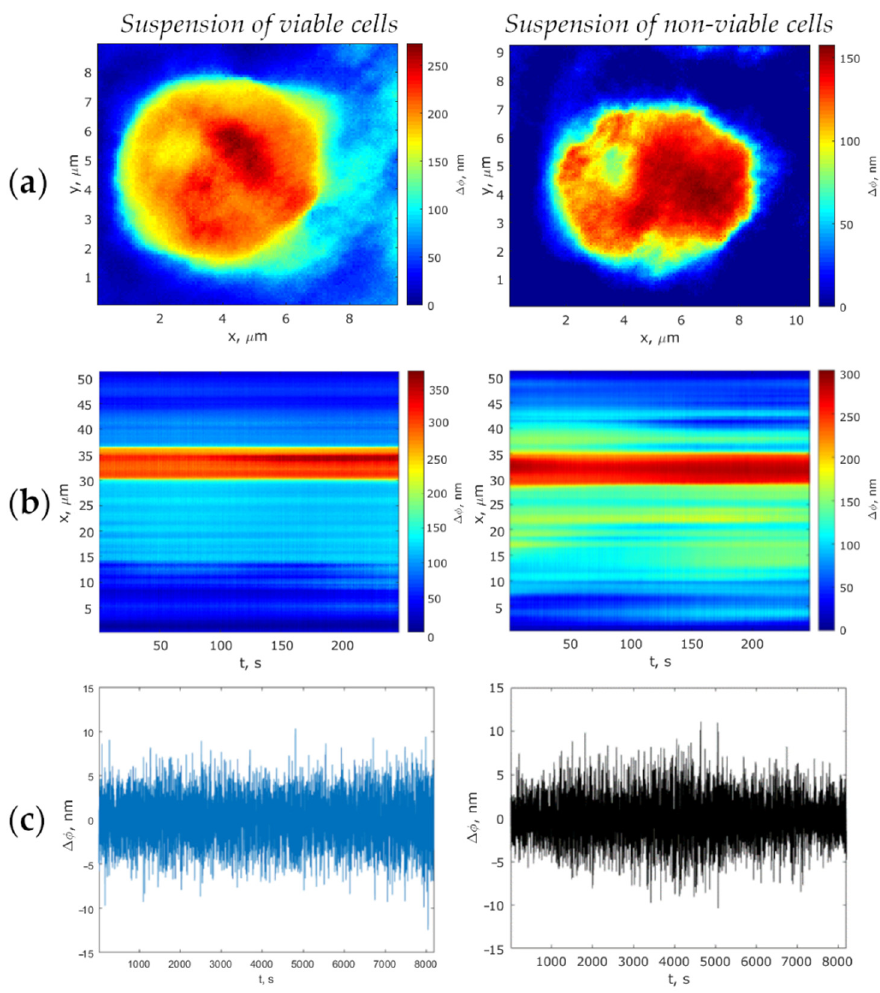
Figure 4. Comparison of viable and non-viable suspended cells: ( a ) Phase images; ( b ) Track diagrams; ( c ) Phase thickness fluctuations of the cells. In the x-direction, spatial coordinates ( a ), and time ( b , c ) are positioned; in the y-direction, spatial coordinate ( a , b ) and phase thickness ( c ) are positioned.